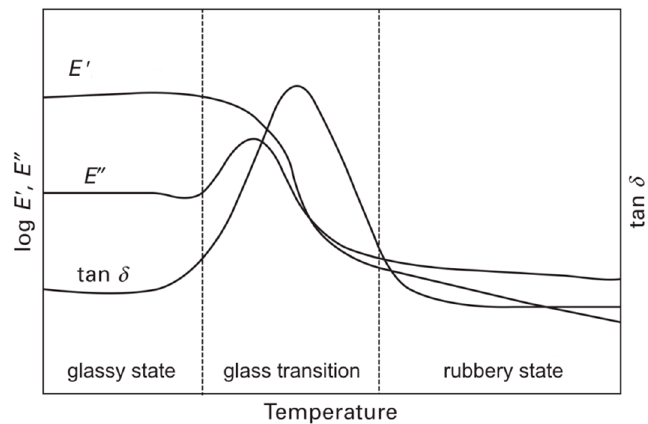
Figure 2. A typical dynamic mechanical analysis (DMA) curve of thermoset polymer.